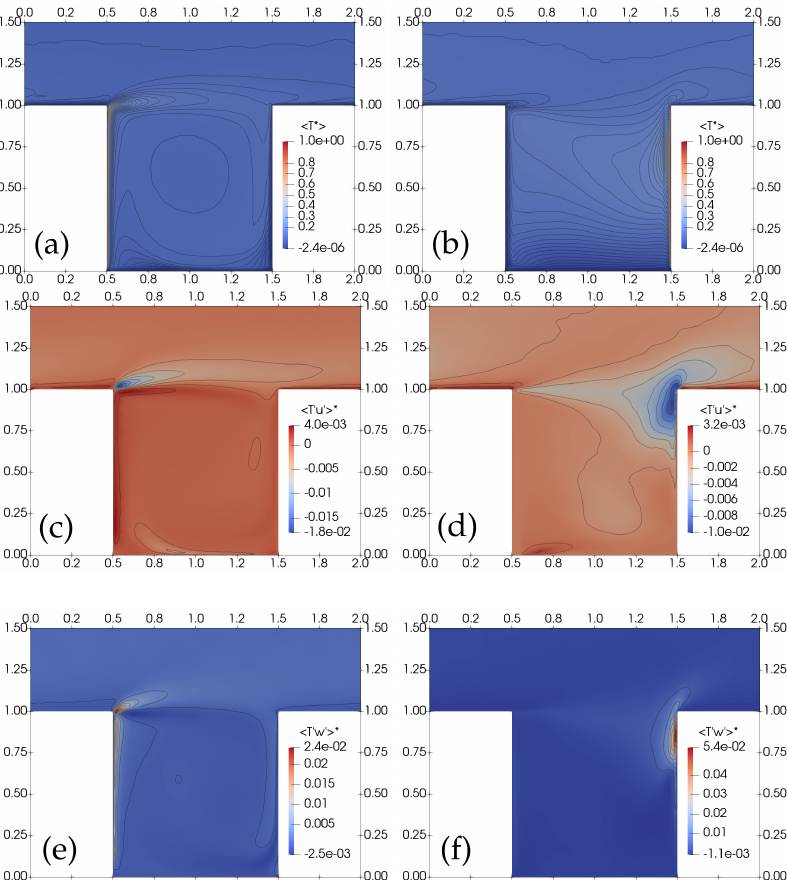
Figure 4. Non-dimensional mean temperature, streamwise and vertical thermal fluxes distribution at a vertical plane perpendicular to the canyon ( y / H = 1) for the thee cases under consideration: first column, favourable case; second column, adverse case. ( a , b ) Temperature. ( c , d ) Horizontal thermal fluxes (cid:104) T (cid:48) u (cid:48) (cid:105) ∗ = (cid:104) T (cid:48) u (cid:48) (cid:105) / ∆ TU 0 ). ( e , f ) Vertical thermal fluxes (cid:104) T (cid:48) w (cid:48) (cid:105) ∗ = (cid:104) T (cid:48) w (cid:48) (cid:105) / ∆ TU 0